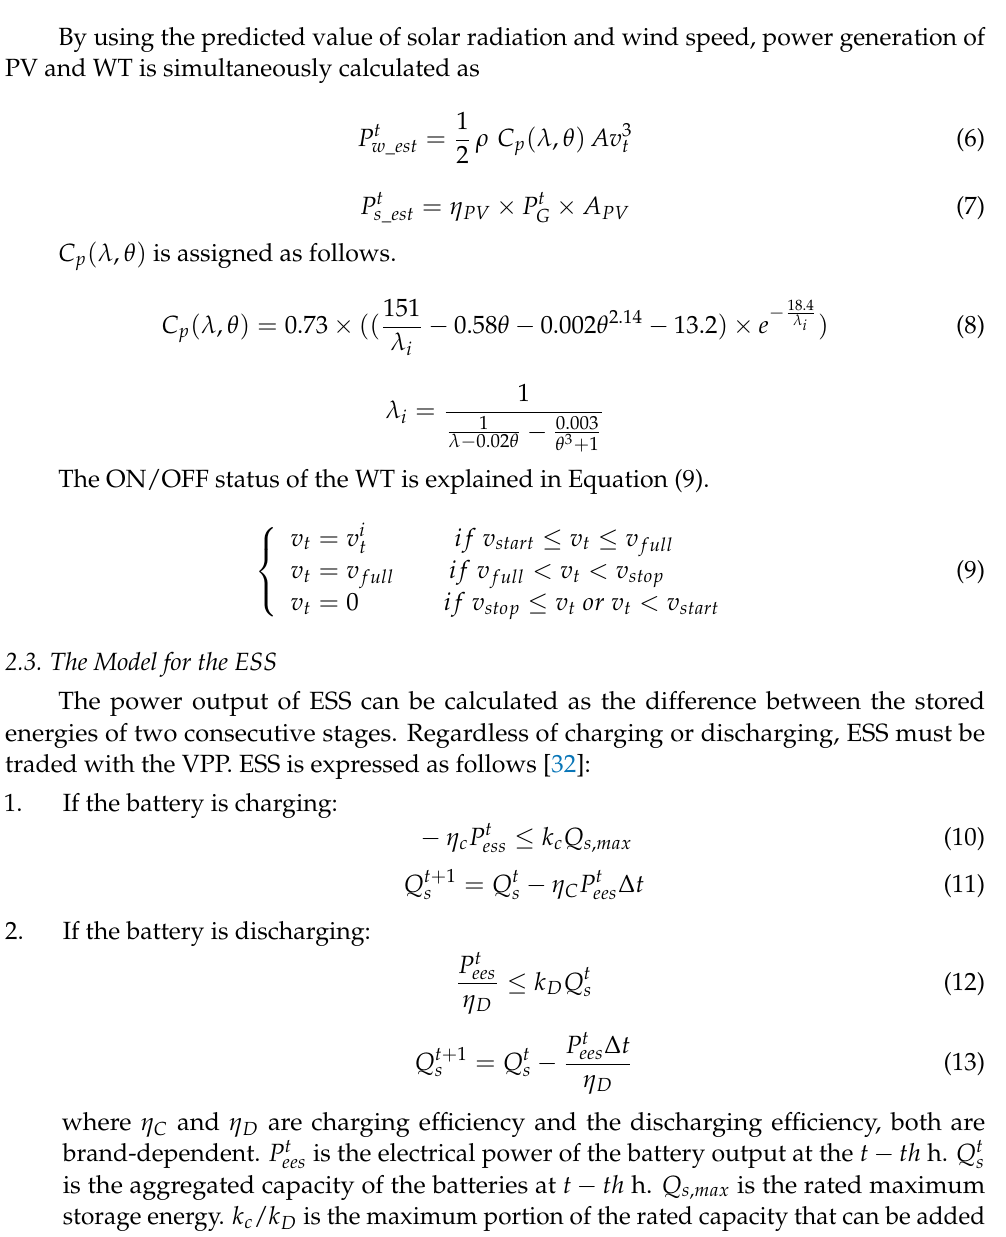
Figure 3. The wind speed/global radiation forecasting using the